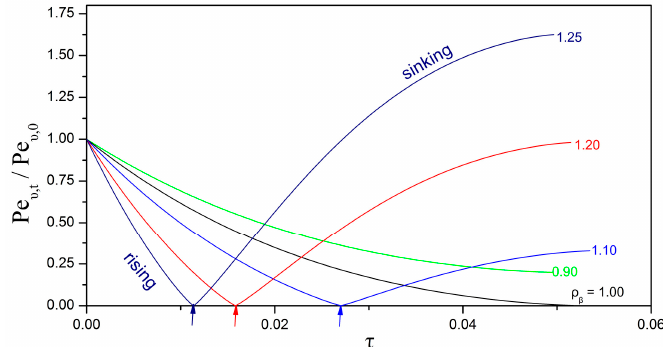
Figure 7. Impact of the biofilm density on the evolution of the Péclet number for a shrinking compound particle that freely rises/falls in a water column. The compound particle becomes neutrally buoyant at the time instants indicated by the arrows. The parameter values are: Pe (cid:3100),(cid:2868) = 100 ; δ (cid:3081),(cid:2868) = 0.1 ; ℎ (cid:3021) = 0 ; Da (cid:3100) = 0 ; Λ (cid:3002)(cid:3081) = 1 ; (cid:1834) (cid:3002),(cid:3100)/(cid:3081) = 1 ; (cid:1863) (cid:3046)(cid:3045)(cid:3041) = 0 ; (cid:1851) (cid:3081)/(cid:3002) = 0 ; (cid:2025) (cid:3090) = 0.85 .